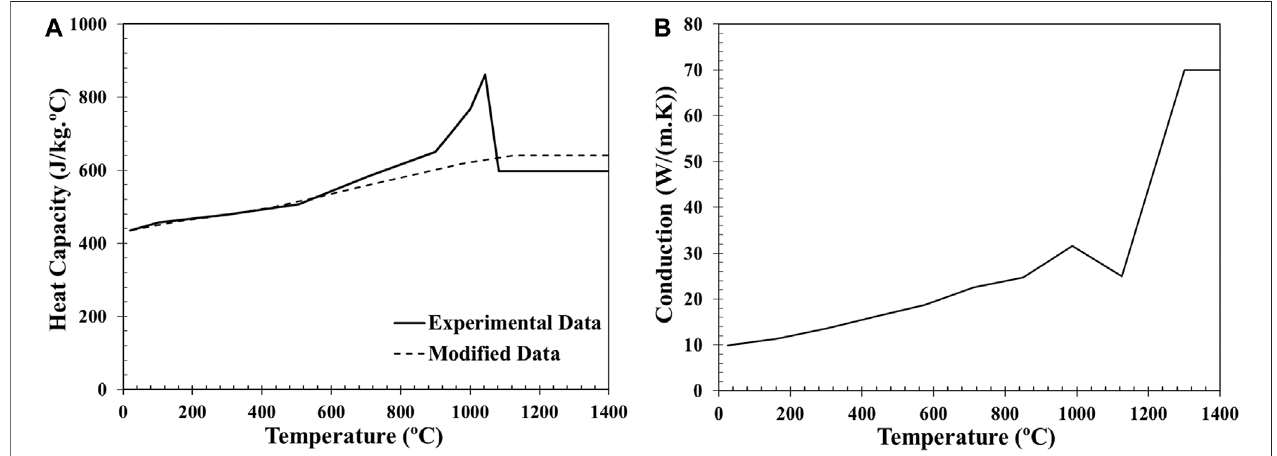
FIGURE 3 | (A) Experimental and modi fi ed temperature-dependent speci fi c heat capacity and (B) heat conduction as a function of temperature for R65.